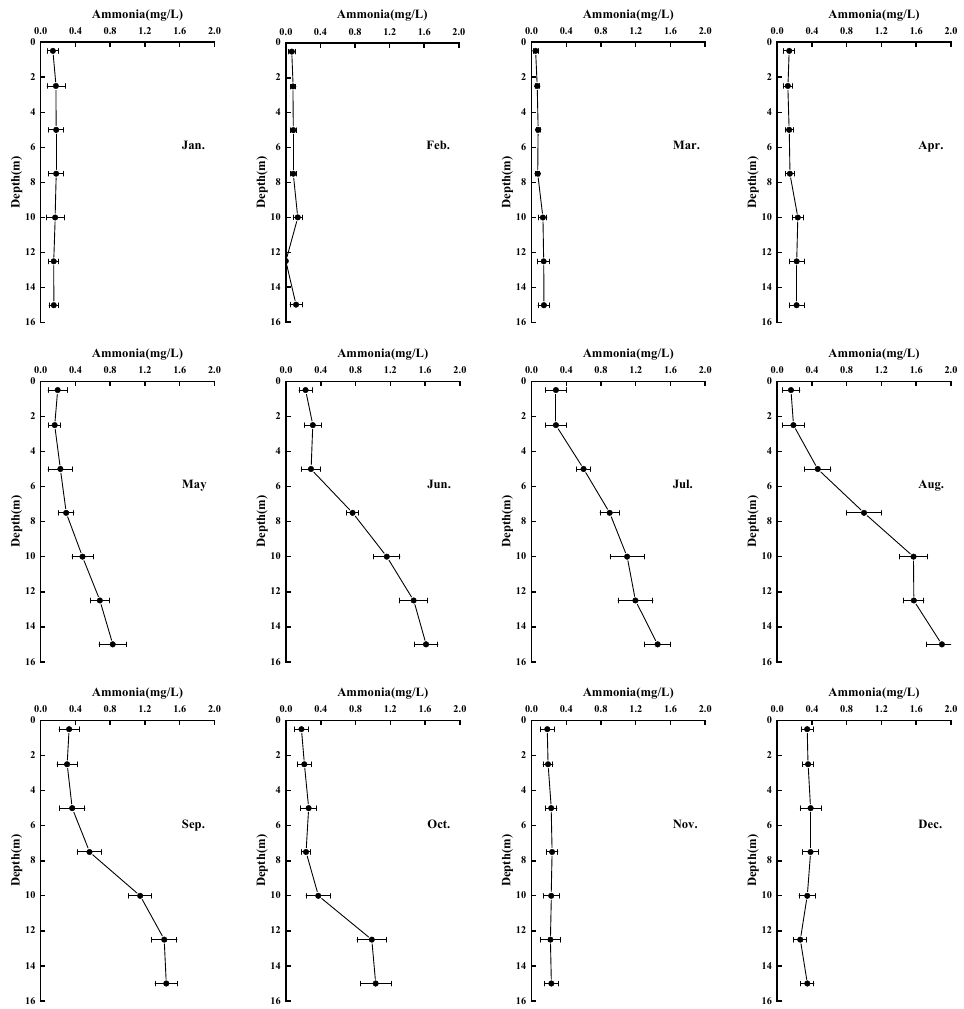
Figure 5. Variation of the vertical distribution of ammonia in ZCR. The concentration of ammonia in the hypolimnion reaches the peak level in August (1.85 mg · L − 1 ). At this time, the vertical distribution of ammonia becomes obviously stratified. The concentration of ammonia in the surface water is much lower than that in the hypolimnion. The maximum value of the surface water ammonia concentration occurs in December when the thermal stratification has disappeared (0.36 mg · L − 1 ).